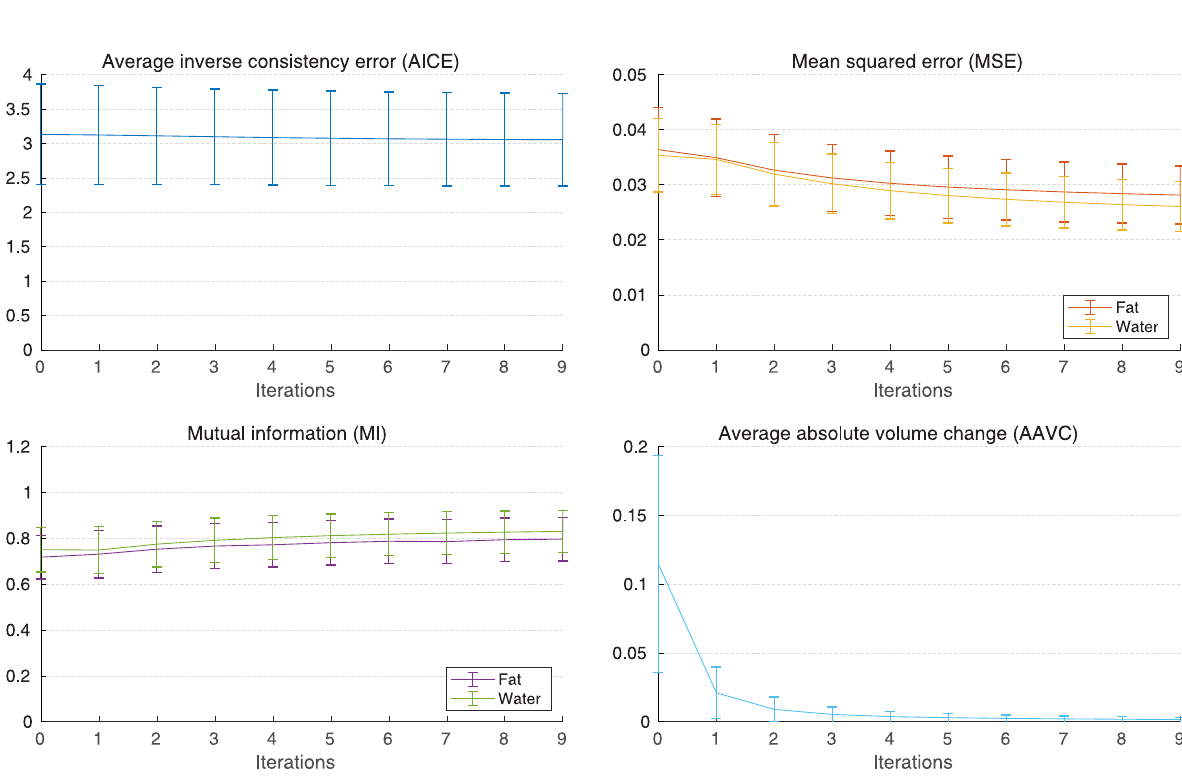
Fig 4. Evaluation of the method stability. Evolution of mean and standard deviation of the measures over the iterations, when iteratively repeating the registration and generation of the synthetic reference. Iteration 0 represents the registration on the initial reference. In the plot of AAVC, to compute the average among the voxels in reference space (Eq 2), outlier voxels whose absolute volume change differs from the median by more than 2.5 times the median absolute deviation were excluded. The data for each subject is reported in S3 File. https://doi.org/10.1371/journal.pone.0222700.g004 PLOS ONE | https://doi.org/10.1371/journal.pone.0222700 October 1,